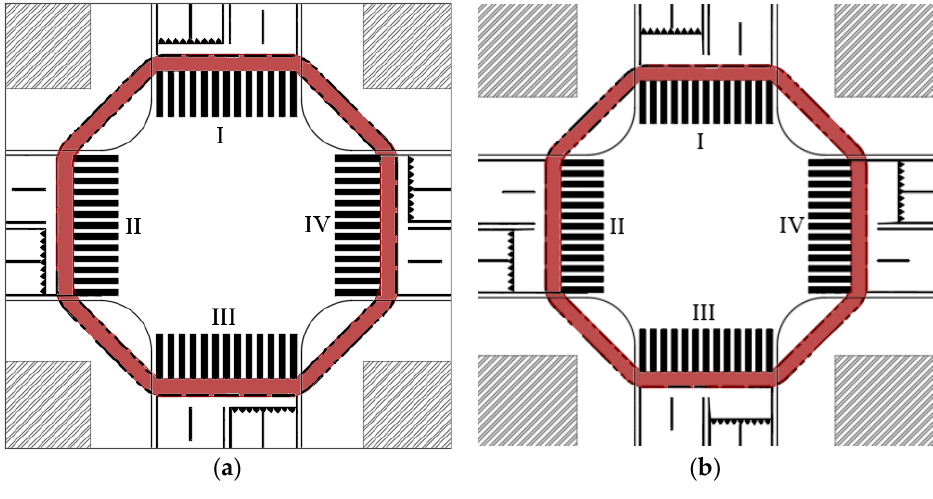
Figure 3. ( a ) Layout of L10; ( b ) layout of L11.